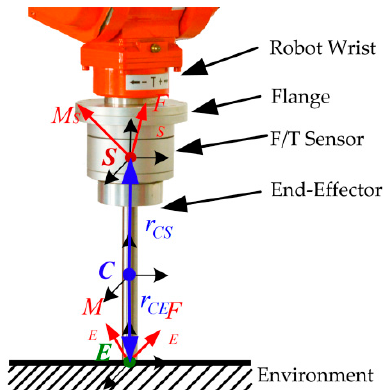
Figure 2. Contact force and moment applied at the end-effector.